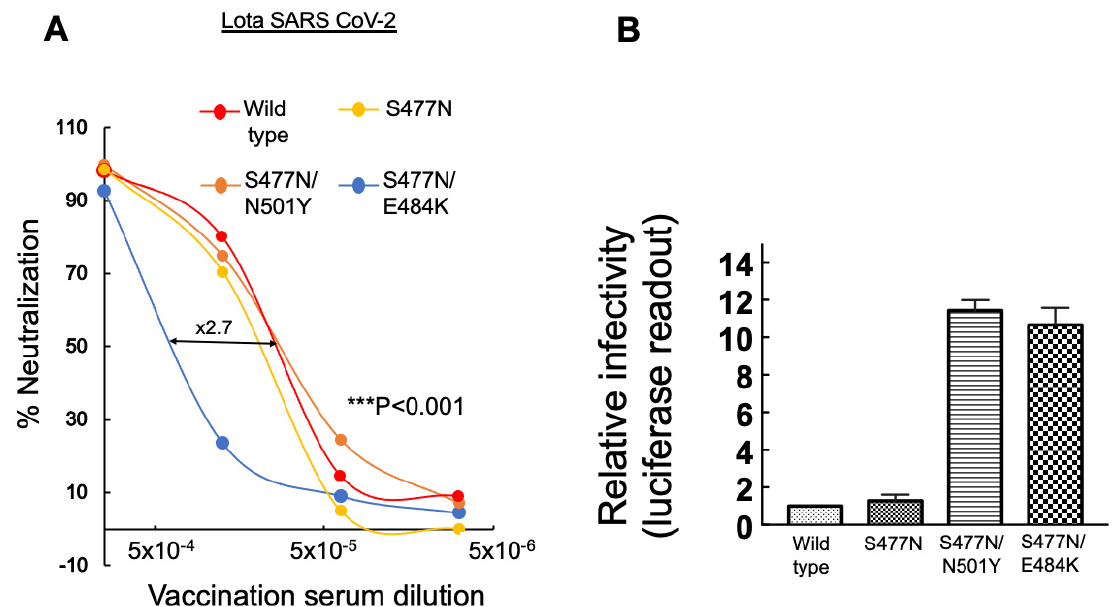
Figure 5. Infectivity levels and neutralization sensitivity of lota-SARS-CoV-2 variant of interest. ( A ) Effects of N501Y and E484K-RBD mutations on neutralizing potential of post-vaccination sera against pseudoviruses displaying S477N spike mutation-neutralization assays were performed by transducing HEK293T-ACE2 cells with a pseudovirus displaying a wild-type SARS-CoV-2 spike carrying B.1.526 (S477S) mutant, in the presence of increasing dilutions of sera drawn from post vaccinated individuals. In addition, 48 h post transduction, cells were harvested and their luciferase readings were monitored. Neutralizing potency was calculated at increased serial dilutions, relative to transduced cells with no sera added. Neutralization, NT 50 , is defined as the inverse dilution that achieved 50% neutralization. Results are the average of two independent biological experiments. Triplicates were performed for each tested serum dilution. Black bars represent a geometric mean of NT 50 values, indicated at the top. Statistical significance was determined using a one tailed t -test *** < 0.001. ( B ) Effects of N501Y and E484K RBD of mutations on infectivity levels of pseudoviruses displaying S477N spike mutation-pseudoviruses bearing wild-type or lota-B.1.526 SARS-CoV-2 spike mutations (S477S/E484K) or its single S477N spike mutants were used to transduce HEK-ACE2 cells. Equal viral loads were normalized based on p24 protein levels. Furthermore, 48 h post transduction, cells were harvested and their luciferase readouts were monitored. Bar graphs show mean values ± SD error bars of three independent experiments. Measured statistical significance was calculated between experiments by a two-tailed Student’s t -test *** p ≤ 0.001.